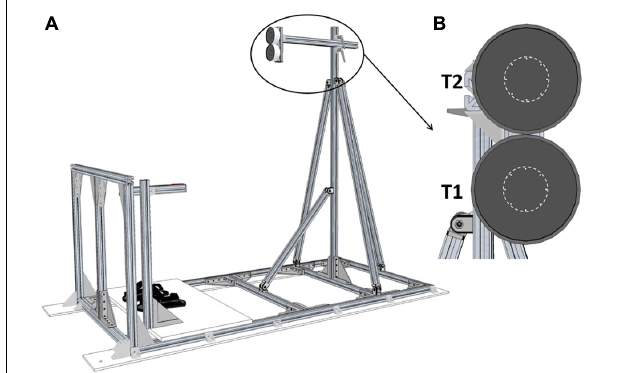
FIGURE 1 | Experimental setup. (A) Global view of the pointing structure including targets, start push-button and footstraps. (B) Front view of the two targets. T1 and T2 were separated by 10 cm. The dotted line represents the area to be reached (Ø 4